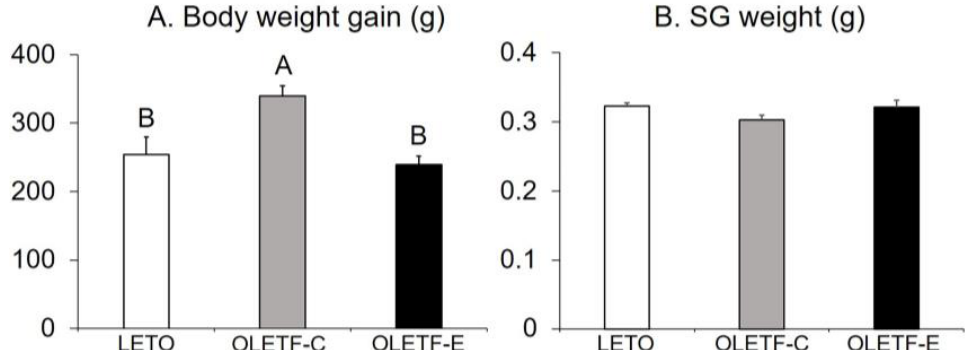
Figure 1. Body weight gain ( A ) and submandibular gland (SG) weight ( B ) 16 weeks after the start of this study. n = 5 per group. Bars represent mean values, and error bars represent the SE. Significant differences were determined using the one-way ANOVA, followed by multiple comparisons using Tukey’s post-hoc test. The letters represent a significant difference in body weight gain between different groups ( p < 0.05, Tukey’s post-hoc test). There were no differences in the SG weight among the three groups ( p = 0.2, one-way ANOVA).